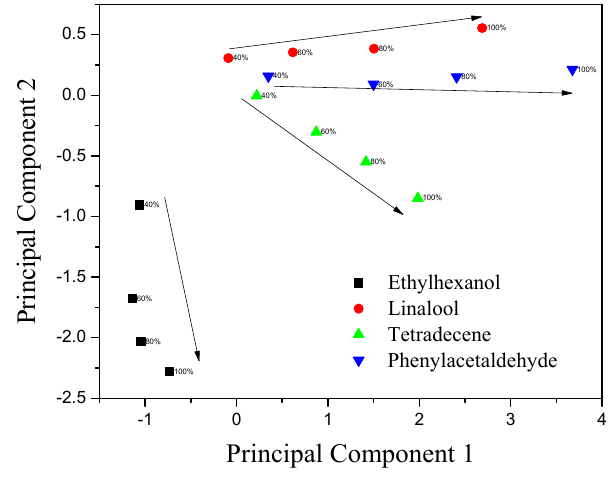
Figure 10. Principal component analysis (PCA) plot (PC1 vs. PC2) of scores using three sensors (bare SWNTs, s1DNA-SWNTs, and s2DNA-SWNTs) showing well-separated clusters for the four volatile organic compounds (VOCs) tested.